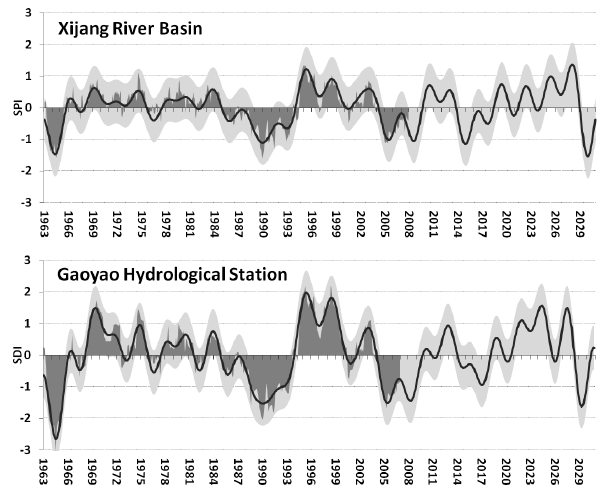
Fig. 13. Observed (dark grey shadings) and reconstructed time se- ries (black line; confidence interval = light grey shading) plus ex- trapolation (starting in 2007) of the SPI-24 (upper panel) and SDI- 24 (lower panel) of the Xijiang River basin and Gaoyao hydrologi- cal station,